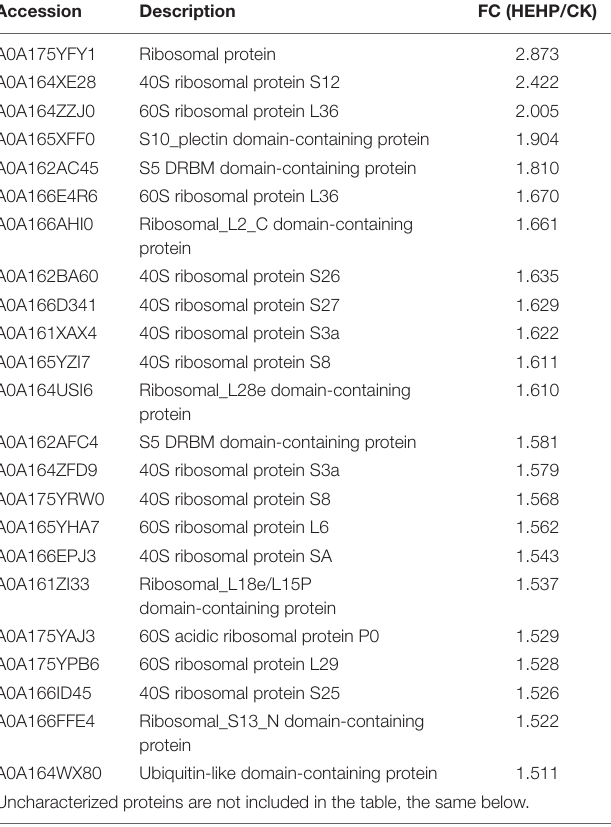
TABLE 1 | Upregulated DAPs involved in ribosome (pathway ID: map03010) in HEHP vs. CK.